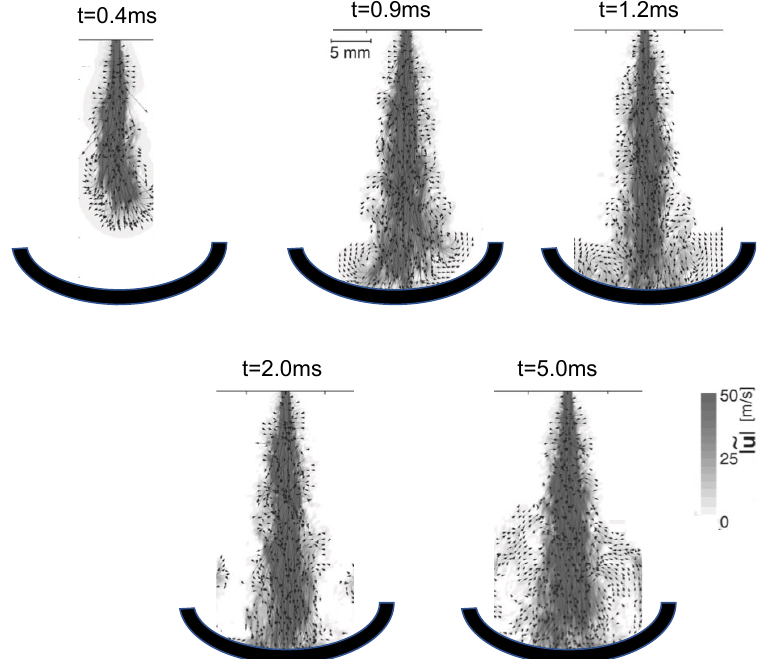
Figure 6. Velocity field of curved impinging spray analyzed by PIV.